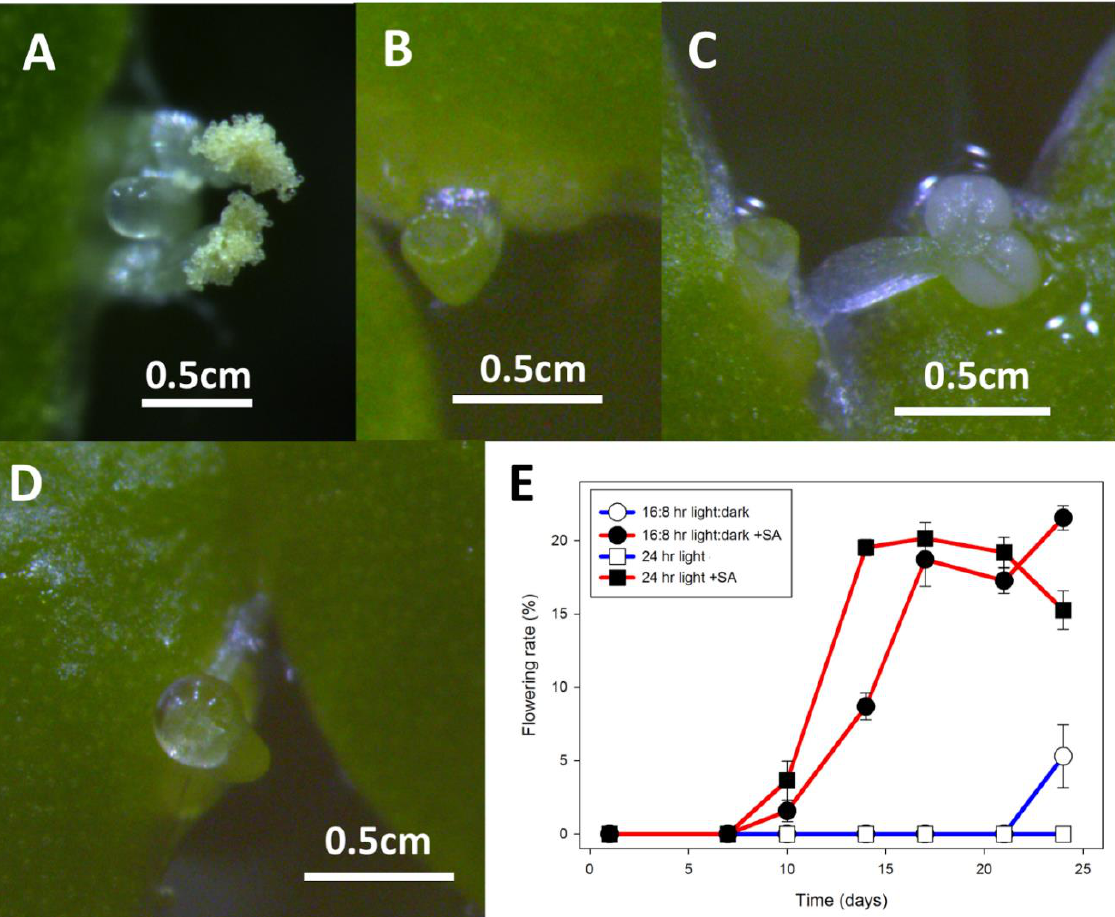
Figure 7. Flowering of L, gibba G3 and L. minor strains growing on E medium supplemented with 20 µ M SA. ( A ) L. gibba DWC114 flower with the pistil having secreted a drop of clear stigmatic fluid and pollen on both dehiscent anthers. ( B ) L. minor DWC130 pistil with no stigmatic fluid ( C ) L. minor DWC131 pistil and mature non-dehiscent anther. ( D ) L. minor DWC132 pistil with a drop of stigmatic fluid. ( E ) Flowering of L. gibba G3 DWC114 on E supplemented with 20 µ M SA is independent of LD or CL lighting conditions. Data are the average ± SEM ( n =